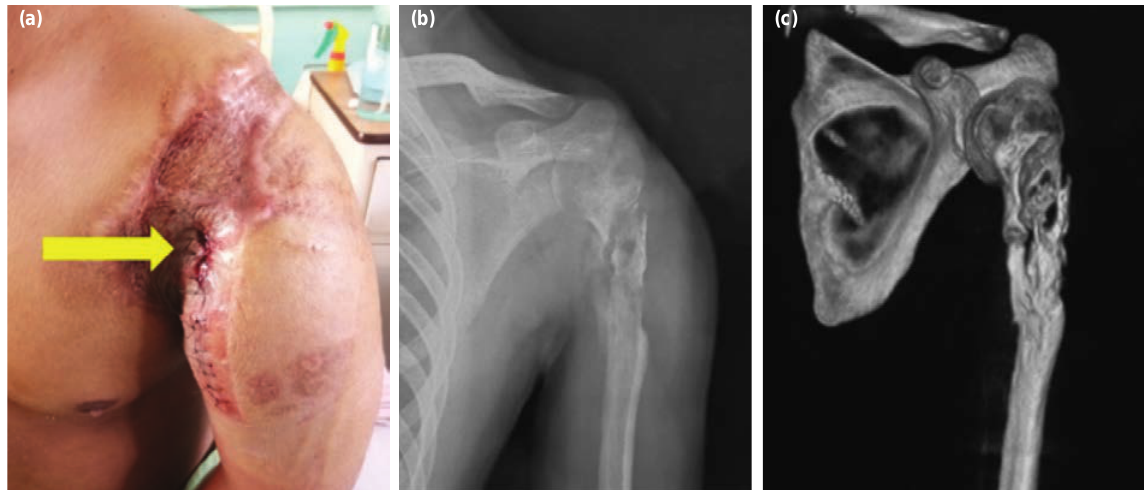
(a) Two months after the initial surgery, he presented with persistent sinus discharge (yellow arrow) at the anterolateral aspect Fig. 2: of his left shoulder. (b) Plain radiograph of the left humerus showed sequestrum located at the proximal part of the left humerus. (c) Computed tomography of the left humerus provided a detailed delineation of the sequestrum, thus assisting in the planning of bony resection to remove the